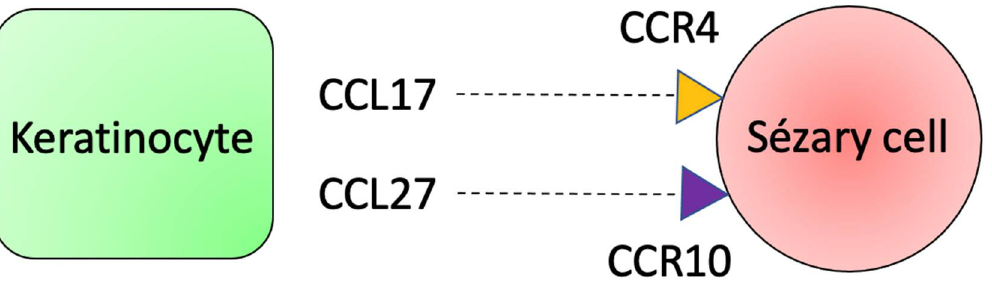
Figure 7. Keratinocytes produce CCL17 and CCL27 that bind to CCR4 and CCR10, respectively. These receptors are expressed by S é zary cells, contributing to the epidermotropism of malignant cells. The CCL26 and CCL11 are also produced by keratinocytes, and they contribute to the migration of eosinophils by interaction with the CCR3, which favors the Th2 response (Figure 8)